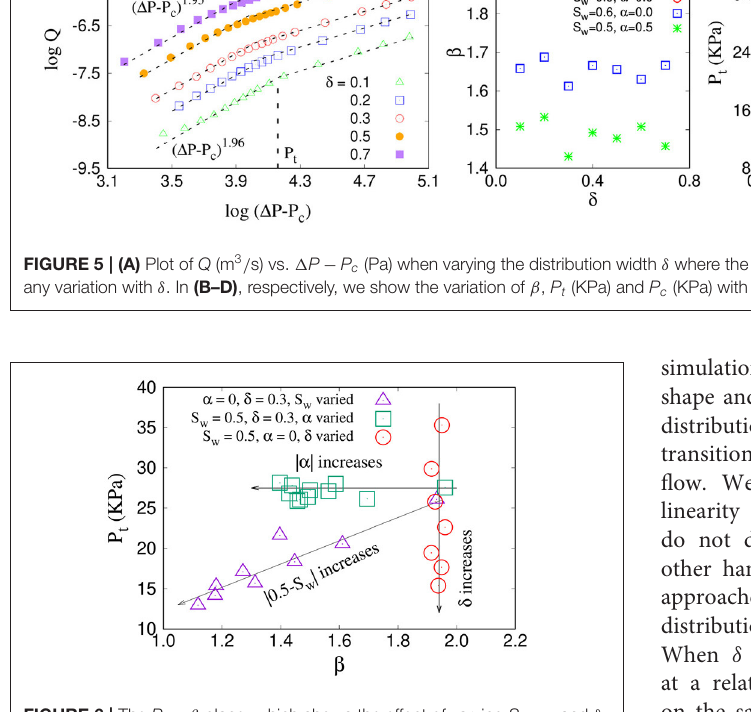
β plane, which shows the effect of varying S w , α , and δ FIGURE 6 | The P t − on the rheological behavior. As S w deviates from 0.5 (triangles), both β and P t decreases. On the other hand, with increasing α (squares) and δ (circles), respectively, either β or P t decreases keeping the other one